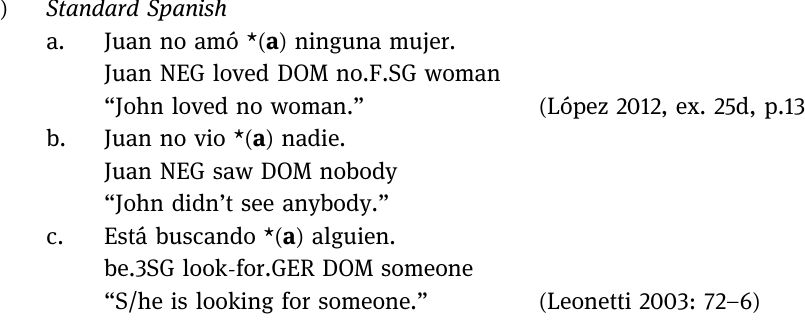
explicit adverbials ( “ in ” phrases, as opposed to “ for ” phrases, Dowty 1979: 133 ff ., a.o. ) or by predicates lexically speci fi ed for boundedness ( 6 - b ) , the di ff erential marker becomes obligatory, as illustrated in ( 6 - b